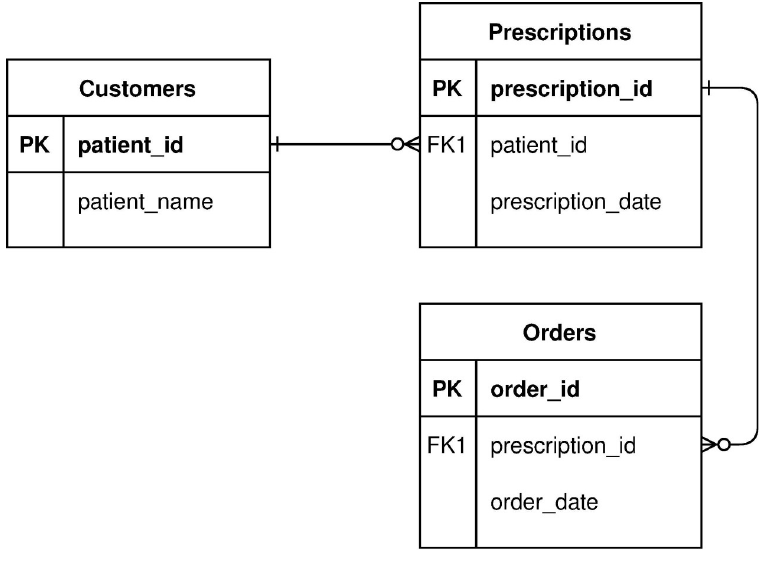
Fig 3. Entity-relationship diagram.